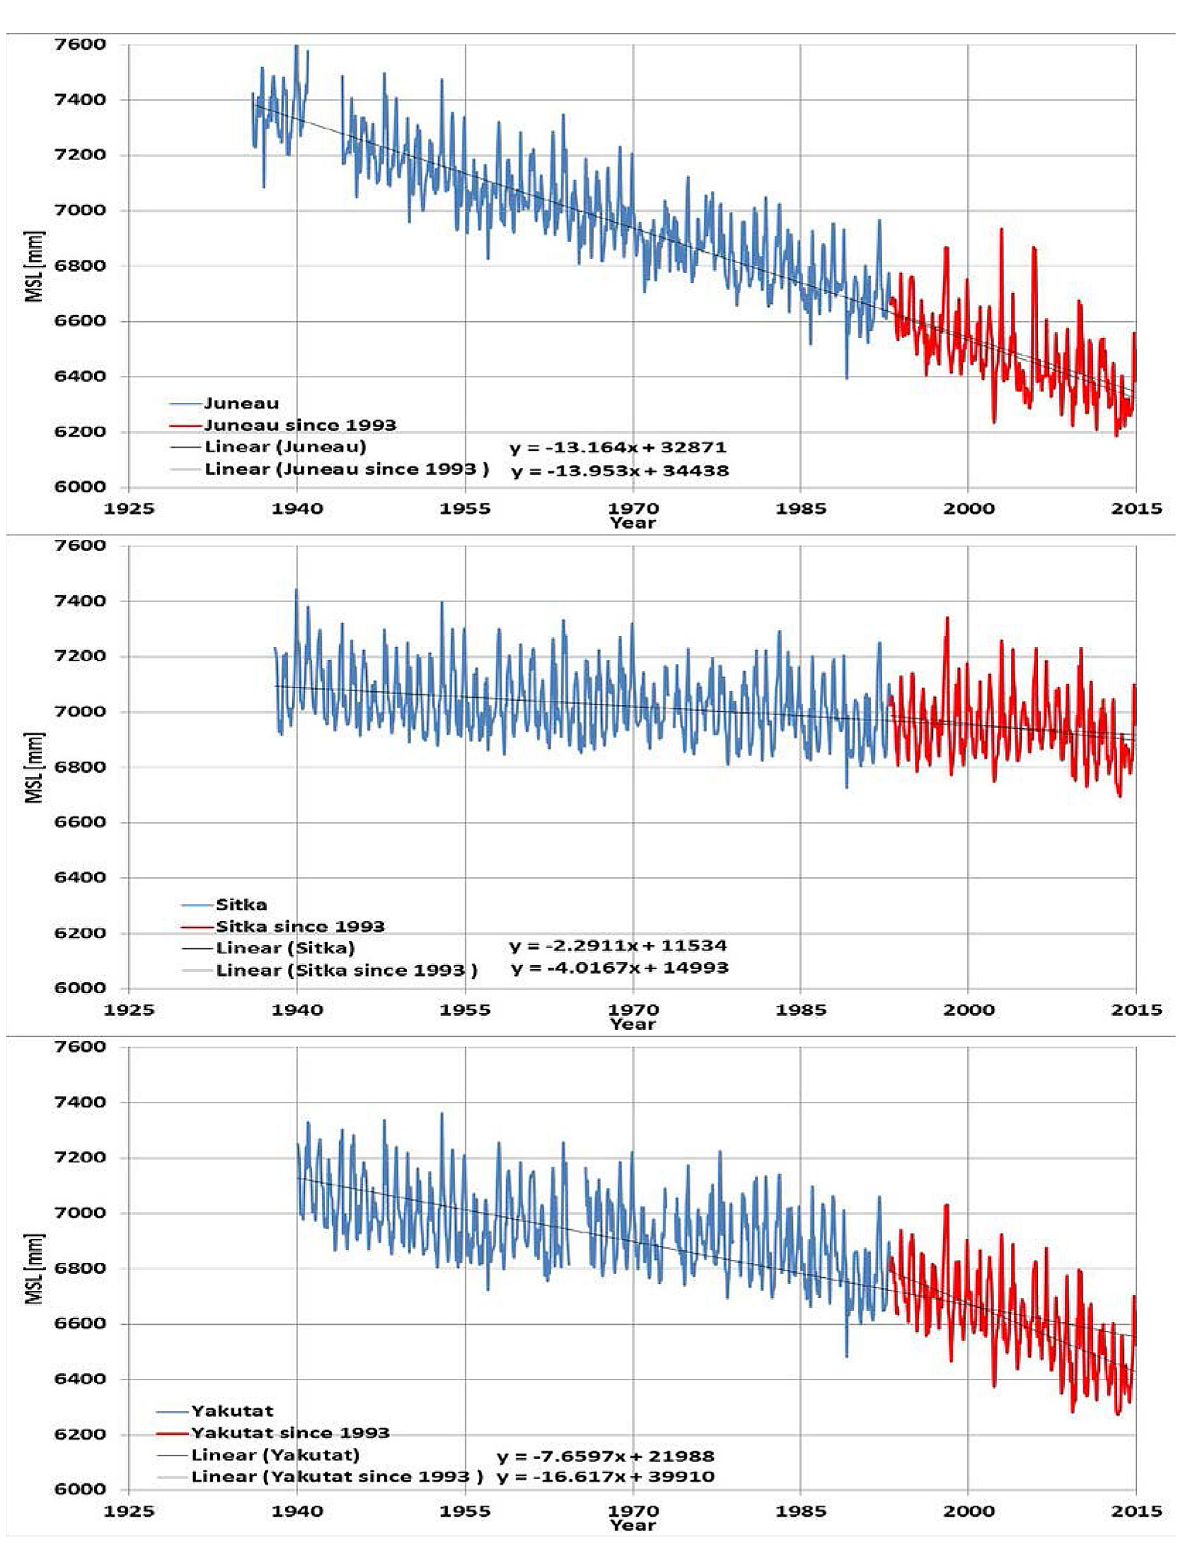
Fig. 3. Relative sea level velocity data in the locations of the US West Coast. Monthly average mean sea levels with the present relative rate of rise for Juneau, Sitka and Yakutat, Ak. data from PSMSL (2015). The short time window for the rate of rise is the time span of the satellite reconstruction of the GMSL. The sea level fall is intensified because of the multi-decadal